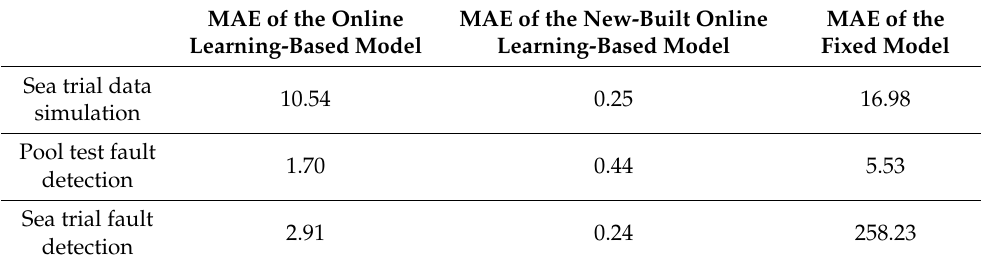
Figure 20. Model residuals of the fixed model-based fault detection method during sea trial of the portable AUV. Table 4. MAE of the propeller speed prediction model.